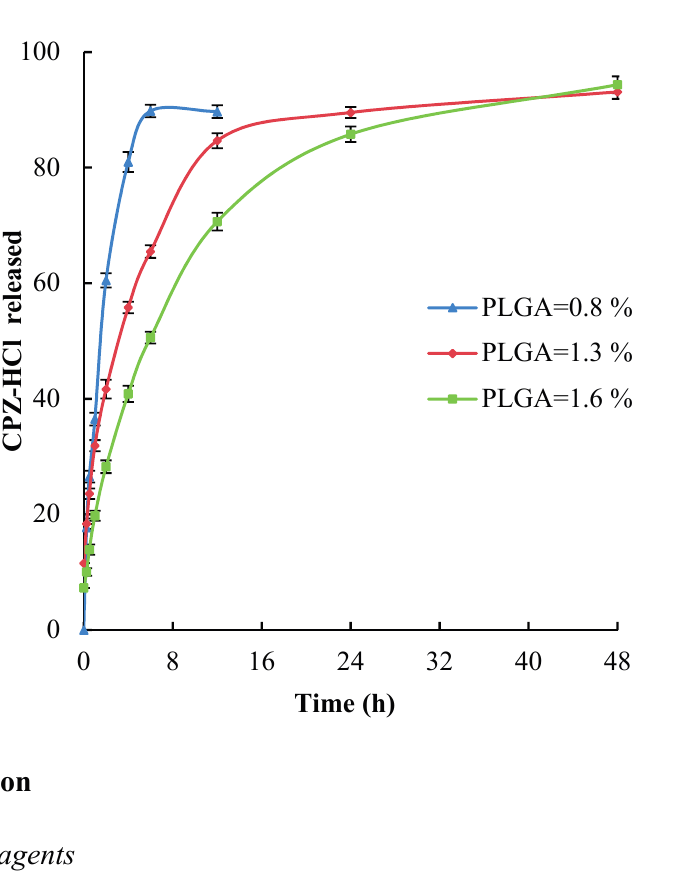
Figure 4. The in vitro CPZ-HCl release profile from NPs at T = 310.15 K in phosphate buffered saline, pH 7.4 for the same amount of drug: Results for different concentration of PLGA ( w / v ): ( ▲ ) 0.8%, ( ♦ ) 1.3%, ( ■ )